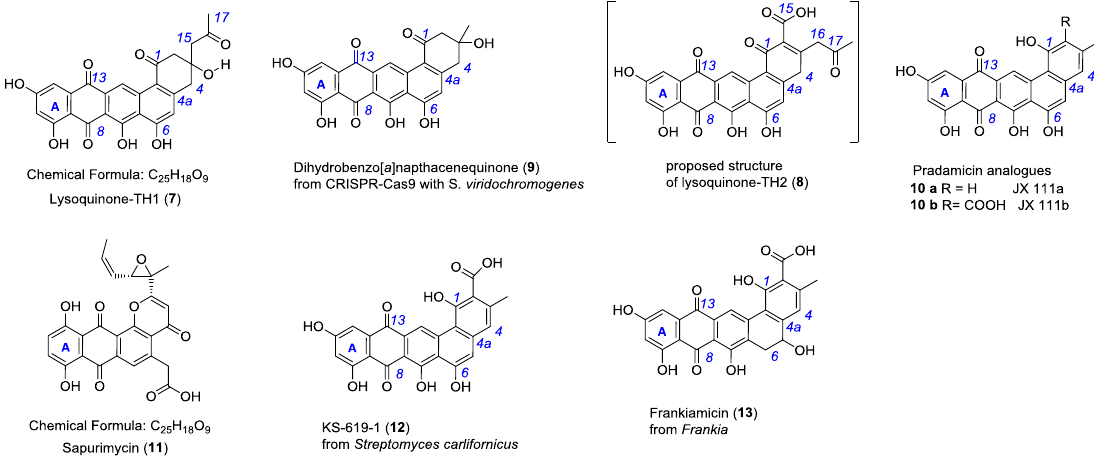
Figure 2. Chemical structure of lysoquinone-TH1 ( 7 , identified), lysoquinone-TH2 ( 8 , proposed), the constitutional isomer sapurimycin ( 11 ) and structurally related pentangular polyketides 9 – 13 .